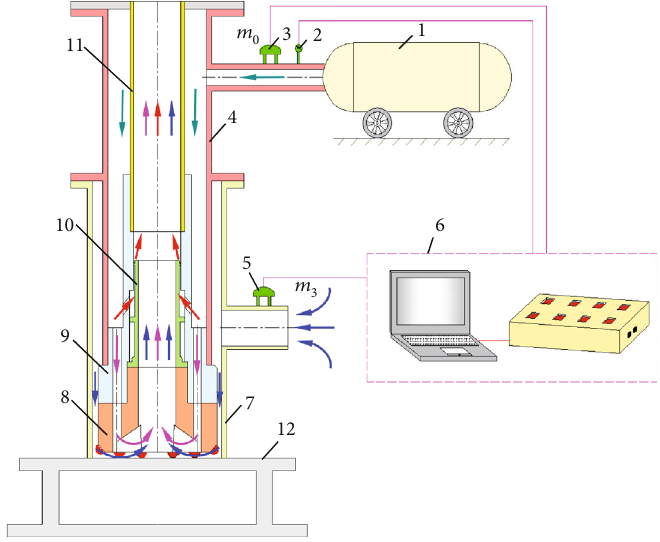
Figure 6: Testing stand of reverse circulation drill bit. 1: air compressor; 2: pressure sensor; 3, 5: air fl ow meter; 4: outer pipe; 6: data collection system; 7: casing; 8: lower part of the drill bit body; 9: upper part of the drill bit body; 10: swirler; 11: inner pipe; 12: frame.